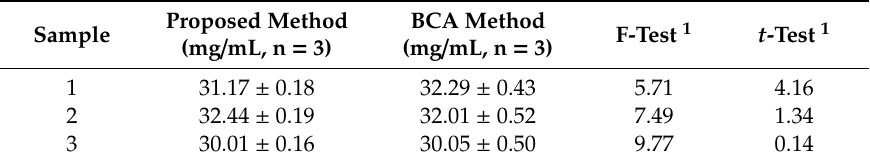
Table 4. The results of milk total protein.